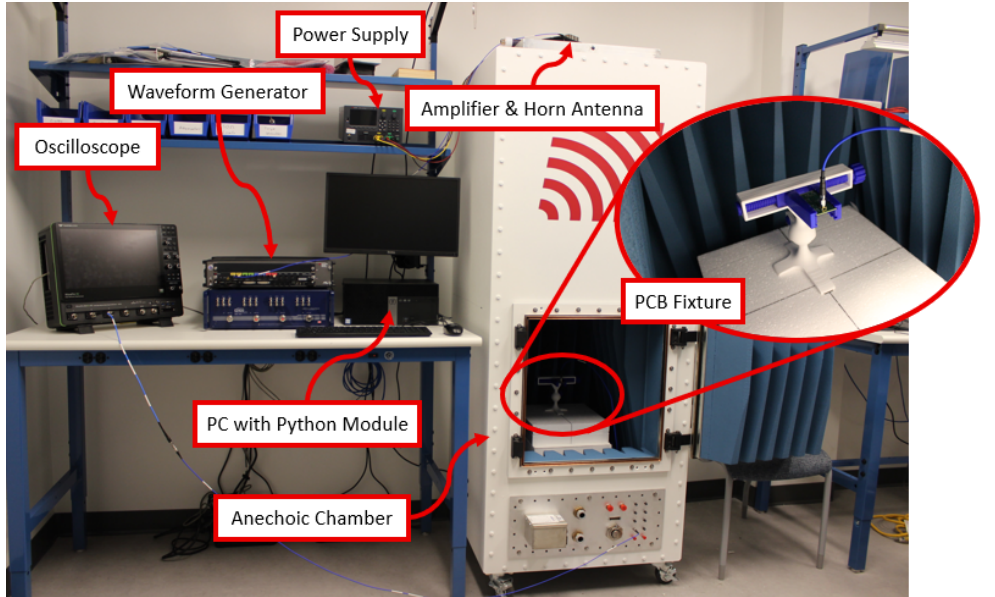
Figure 2. Experimental setup loop for making controlled induced voltage measurements. Signal generation is performed using a waveform generator, power supply, amplifier, and horn antenna. An anechoic chamber is used to mimic free-space conditions in a controlled environment, and a fixture is used for holding the device under test (DUT) at a consistent location and in a consistent orientation. Voltage measurements are performed using an oscilloscope, and a PC with a custom Python module is used to automate the testing